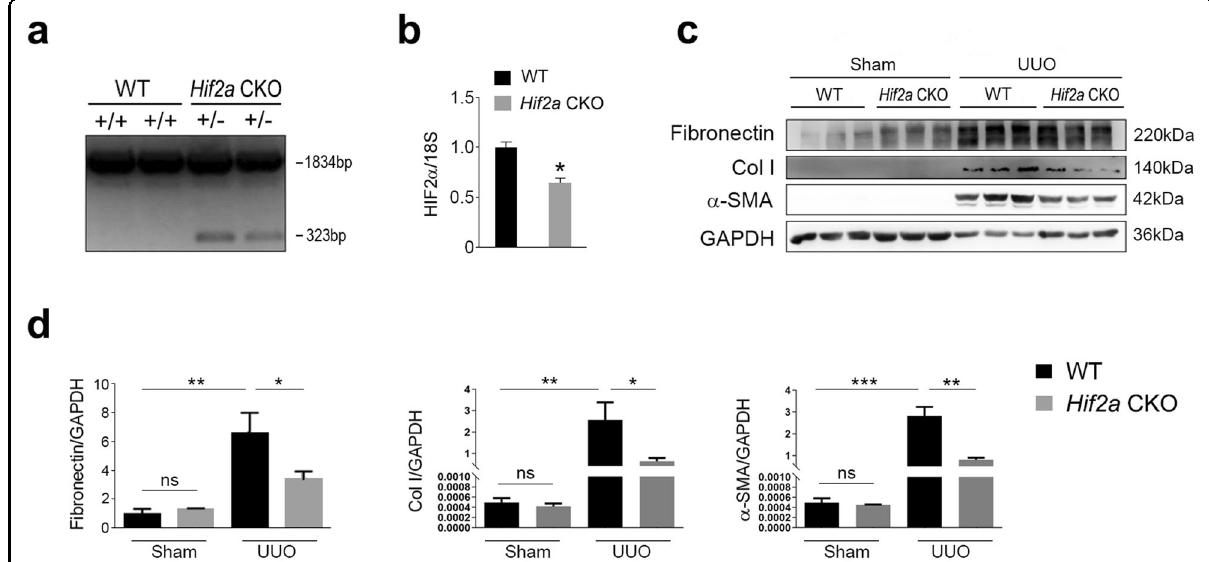
Fig. 5 Hif2a de fi ciency in renal interstitial cells attenuates fi brogenesis induced by UUO injury. a Genotyping for Hif2a CKO mice. The length of PCR products for the wild-type Hif2a allele is 1834 bp, and the length for the knockout Hif2a allele is 323 bp. b HIF-2 α expression was reduced in kidneys from Hif2a CKO mice. Gene expression was analyzed by qRT-PCR and 18S has used a house-keeping gene. c Renal fi brosis was attenuated by Hif2a de fi ciency. Protein levels were analyzed by western blot and GAPDH was used as a loading control. d Quantitative analysis of western blot data as shown in c . n = 6. Data are means ± SEM. ns: no signi fi cance. * P > 0.05, ** P < 0.01, *** P < 0.001.